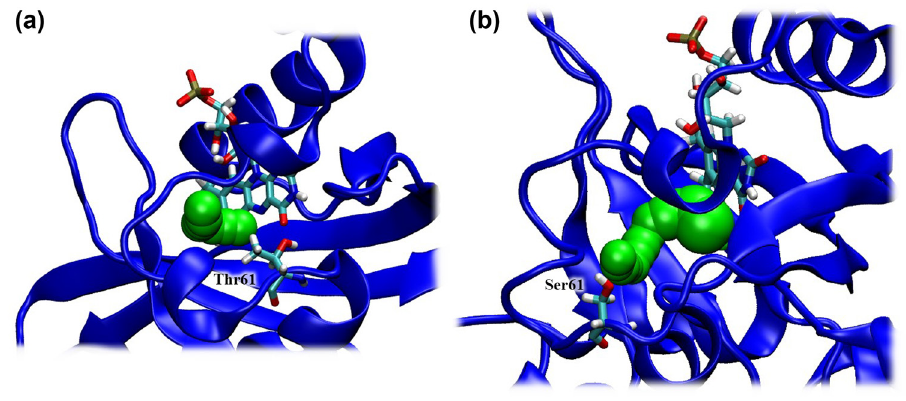
Figure 6: New tunnel connecting outside to the FMN cofactor in the C71S - Y61T ( a ) and C71S - Y61S ( b ) variant.